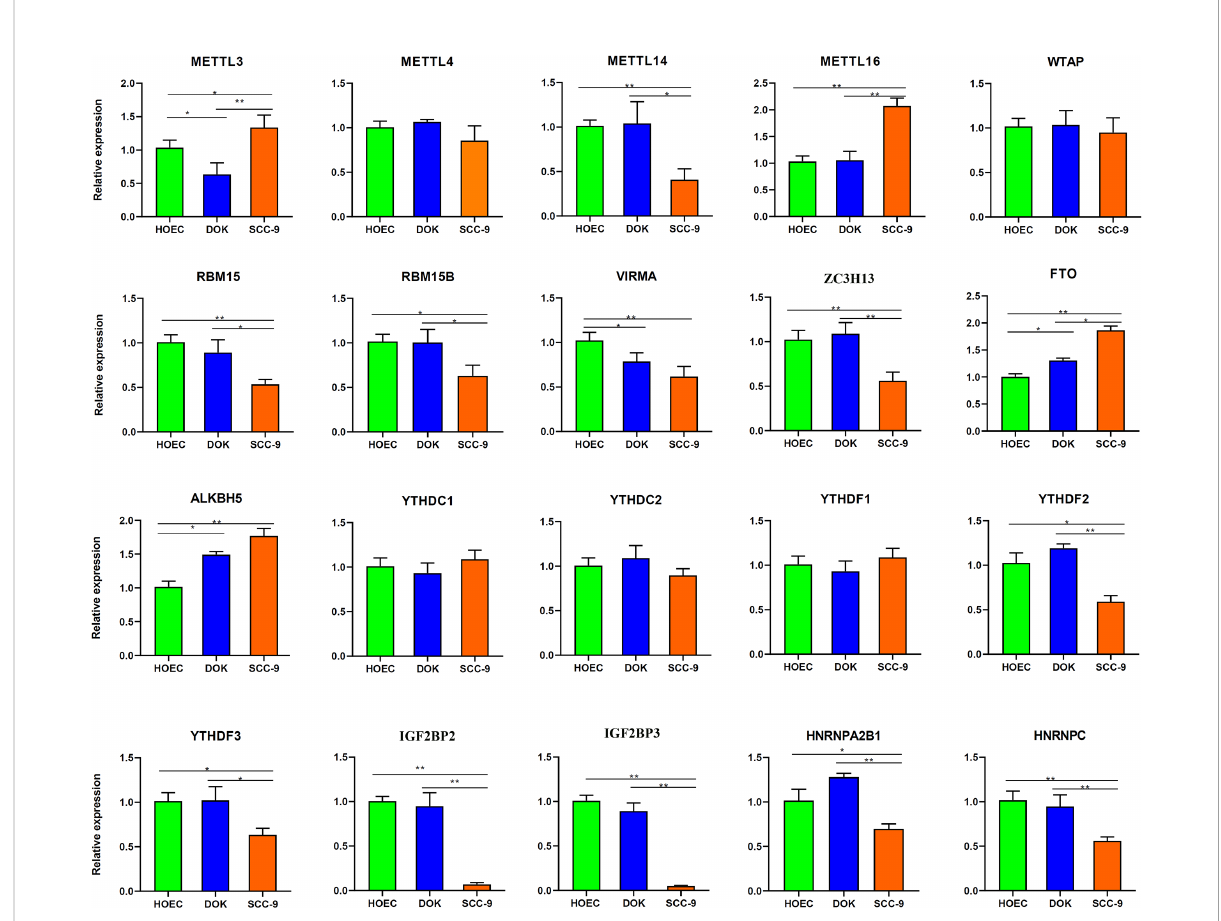
FIGURE 7 Expression of m 6 A regulatory genes in HOEC, DOK and SCC-9 cells detected by real-time RT-PCR. All bars show mean ± SD of three independent experiments. * p < 0.05, ** p <